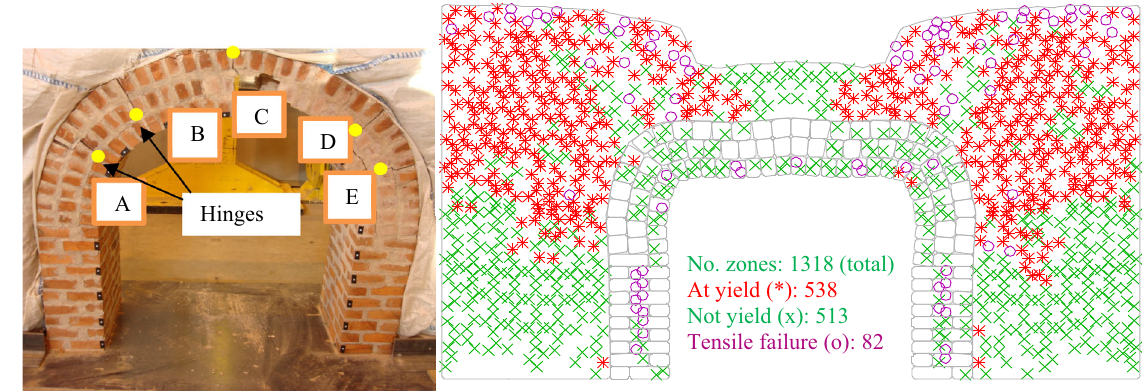
Fig. 9 Plastic state of UDEC C compared with experimental test 3 under concentrated load ( H = 1170 mm) Fig. 10 Failure pattern of UDEC C under concentrated load indicating hinges ( H = 1170